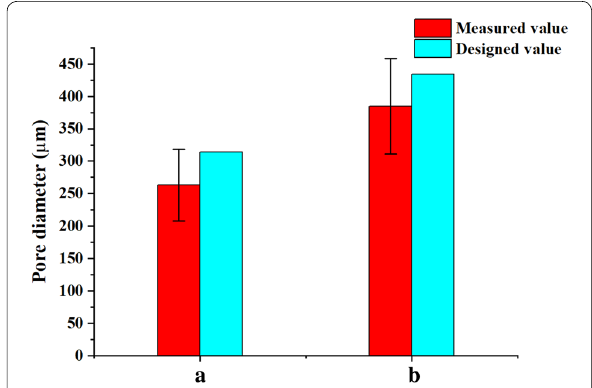
Figure 8 Pore diameter: a designed value 314 μm, b designed value 434 μm